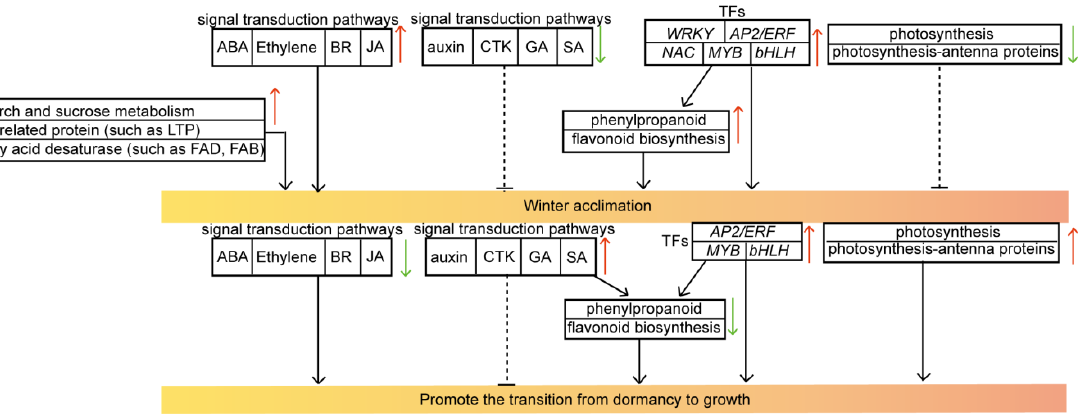
Figure 9. Regulatory network and mechanism of overwintering C. fortunei . Green arrows indicate downregulated expression; red arrows indicate upregulated expression. Black arrows indicate facilitation of winter acclimation or the transition from dormancy to growth, and dashed arrows indicate inhibition of winter acclimation or the transition from dormancy to growth. The abbreviations are as follows: ABA, abscisic acid; AP2/ERF , apetala2/ethylene-responsive factor ; bHLH , basic helix-loop-helix ; CTK, cytokinin; GA, gibberellin; JA, jasmonic acid; MYB , v-myb avian myeloblastosis viral oncogene homolog ; NAC , NAM , ATAF1/2, and CUC2 ; SA, salicylic acid.